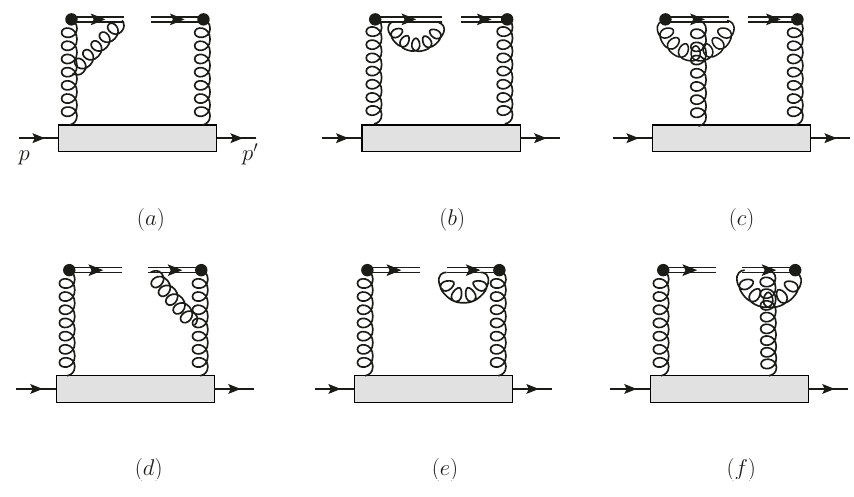
Figure 3 . The one-loop diagrams for virtual corrections to quasi